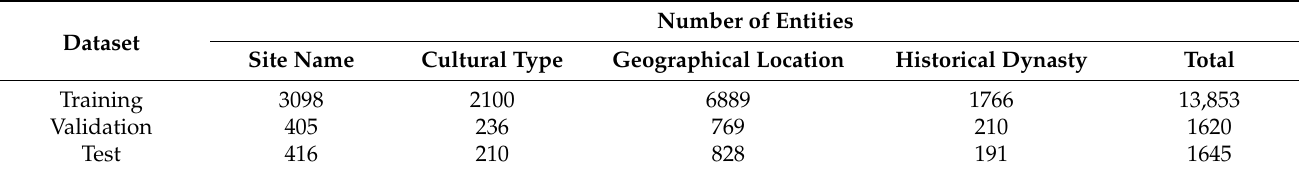
Table 2. Statistics of entities in the datasets.